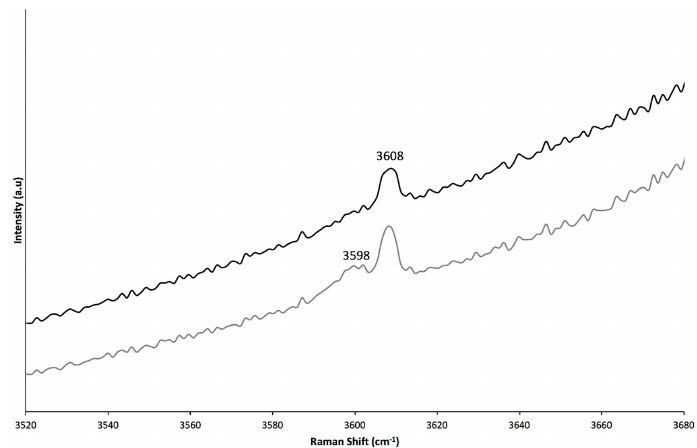
Figure 22. Raman spectra from 3520 to 3680 cm − 1 of an emerald from Colombia. The black and grey spectra are acquired with the laser beam perpendicular to the c-axis and parallel to the c-axis, respectively. Note that the upper spectrum is shifted higher for clarity.